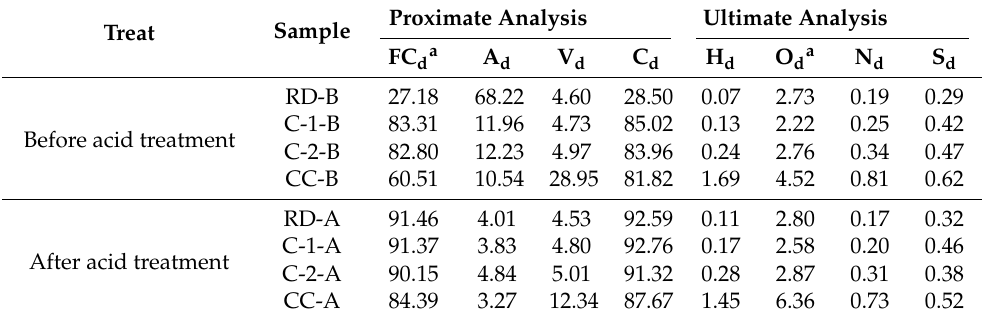
After acid treatment